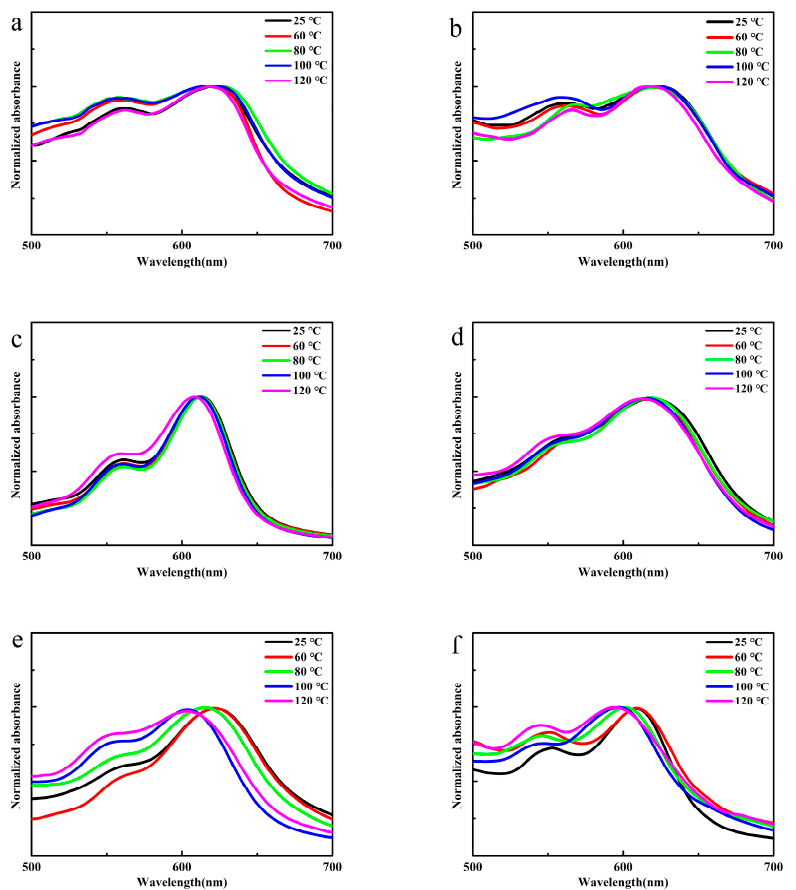
Figure 12. Normalized UV–vis absorption spectra of PBI-1 aggregates after 2 h heating. ( a ) r = 15:1 hydrochloric acid, ( b ) r = 30:1 p-toluenesulfonic acid, ( c ) r = 100:1 malonic acid, ( d ) r = 200:1 citric acid, ( e ) r = 500:1 glutaric acid and ( f ) r = 500:1 adipic acid.